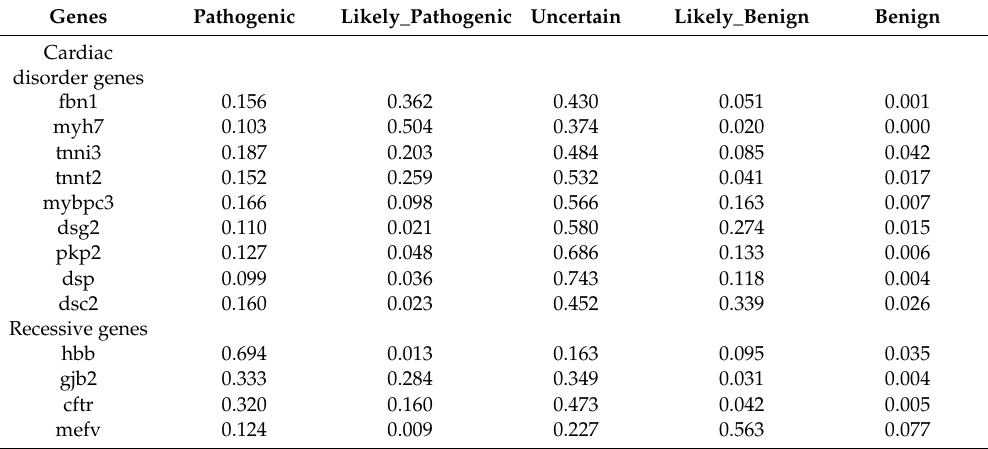
Table 5. Proportions of pathogenicity classes for the selected pathogenic